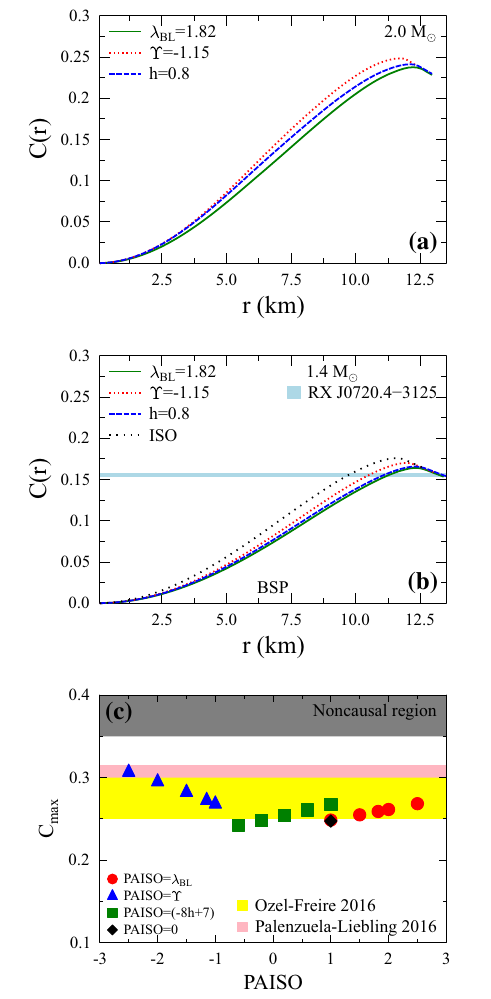
Fig. 10 Impact of anisotropic pressure for all anisotropic pressure models on compactness profiles of NS with a 2 M (cid:3) , b 1.4 M (cid:3) , and c compactness on maximum mass. In b , we include the compactness of one recently measured isolated NS [125], while in c , we include the NS maximum compactness results of Refs. [8,126] for comparisons.